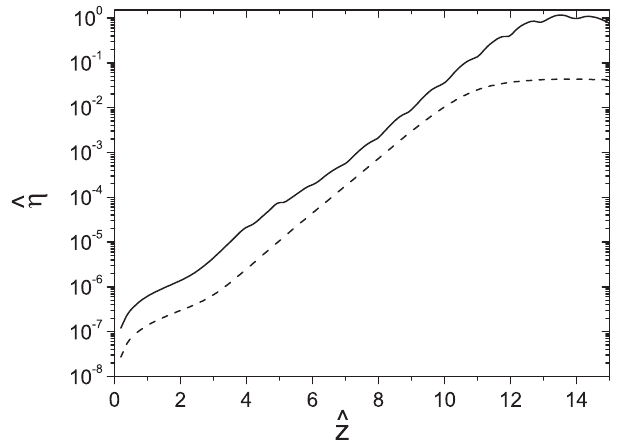
FIG. 9. Normalized power of the fundamental harmonic (solid) and of the third harmonic (dash) versus normalized undulator length for a SASE FEL. Phase shifts are equal to 2 (cid:1)= 3 at the positions ^ z ¼ 4 ; 5 ; 6 ; . . . ; 14 , as suggested in [18]. The undulator parameter is large, K (cid:6) 1 . Definitions of the normalized pa- rameters can be found in